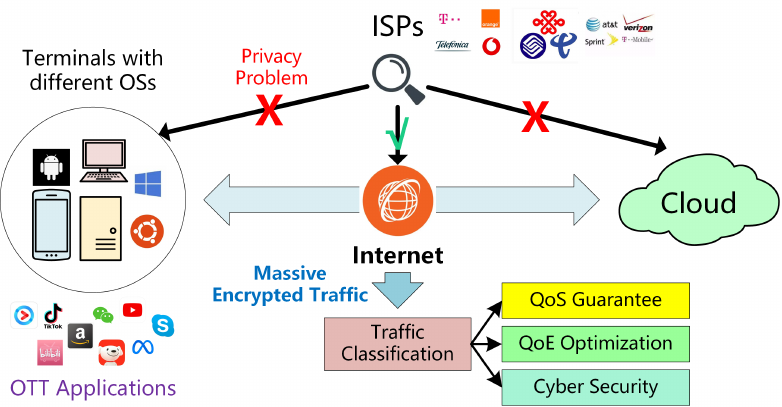
Figure 1. Significance of encrypted traffic classification.